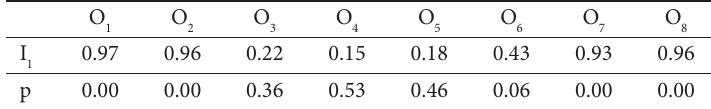
Table 3. Pearson correlation coefficient of input and output